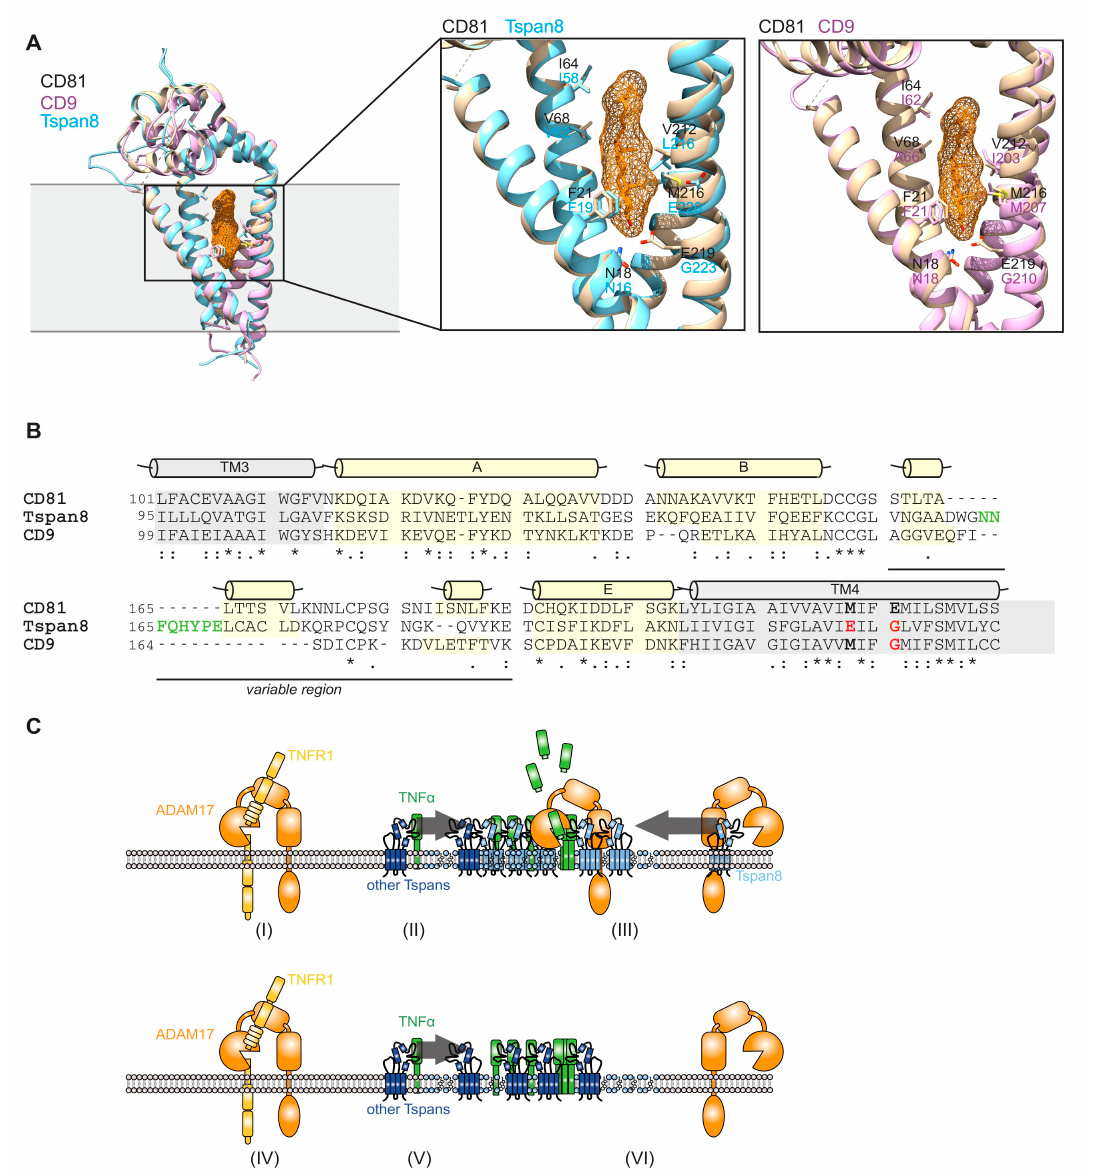
Figure 6. Structural differences in the intramembrane potential cholesterol binding pocket might account for regulation of ADAM17 substrate availability. ( A ) Homology model of CD9 and Tspan8 superimposed onto the crystal structure of CD81 highlight structural differences in the intramembrane potential cholesterol binding pocket. ( B ) Sequence alignment of the large extracellular loop (LEL) region between transmembrane helix 3 (TM3) and transmembrane helix 4 (TM4) reveals differences in sequence and length within the variable region. Amino acid insertions in the Tspan8 LEL are highlighted in green. Variations in amino acids of TM4 contributing to the cholesterol binding pocket in CD81 are marked in red. * denotes amino acid conservation, indicates strong similarity, indicates weak similarity. ( C ) Proposed model for Tspan8-mediated substrate selectivity of ADAM17. (I+IV) Substrates that do not bind to Tspan8 are cleaved outside tetraspanin enriched microdomains (TEMs). (II) Tetraspanins other than Tspan8 recruit TNF α into TEMs. (III) Tspan8 recruits ADAM17 into TEMs, enabling ADAM17-mediated release of soluble TNF α . (V) In the absence of Tspan8, TNF α is still present in TEMs, while (VI) ADAM17 cannot be recruited, therefore reducing TNF α